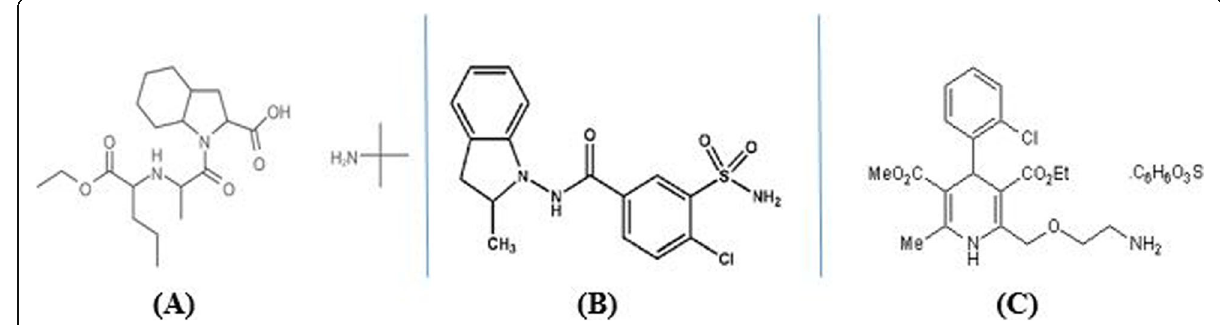
Fig. 1 Chemical structure of ( a ) Perindopril erbumine, ( b ) Indapamide, and ( c ) Amlodipine